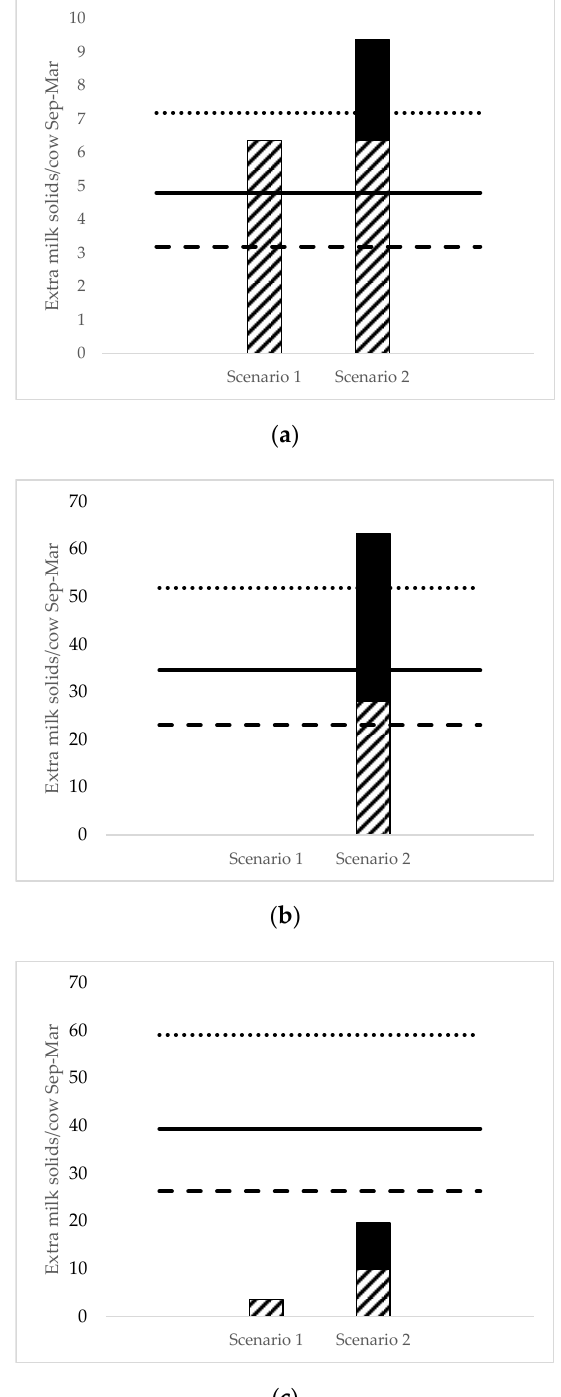
Figure 1. ( a – c ) Estimated extra kg milk solids per cow from 1 September to 31 March (212 days) by cows fed ( a ) BET, ( b ) FAT, and ( c ) BET + FAT experimental diets, compared to cows fed the control diet. Two scenarios are presented; Scenario 1 (benefits from feeding each experimental diet were only accounted for when THI ≥ 75), and Scenario 2 (all benefits from feeding each experimental diet were included). Columns represent extra milk solids produced on days where THI ≥ 75 (hatched) and THI < 75 (solid). Horizontal lines represent the required pre-experimental milk production thresholds (extra kg milk solids/cow) for the ‘High supplement price/low milk price’ (dotted line), ‘Average supplement price/average milk price’ (solid line), and ‘Low supplement/high milk price’ (dashed line)